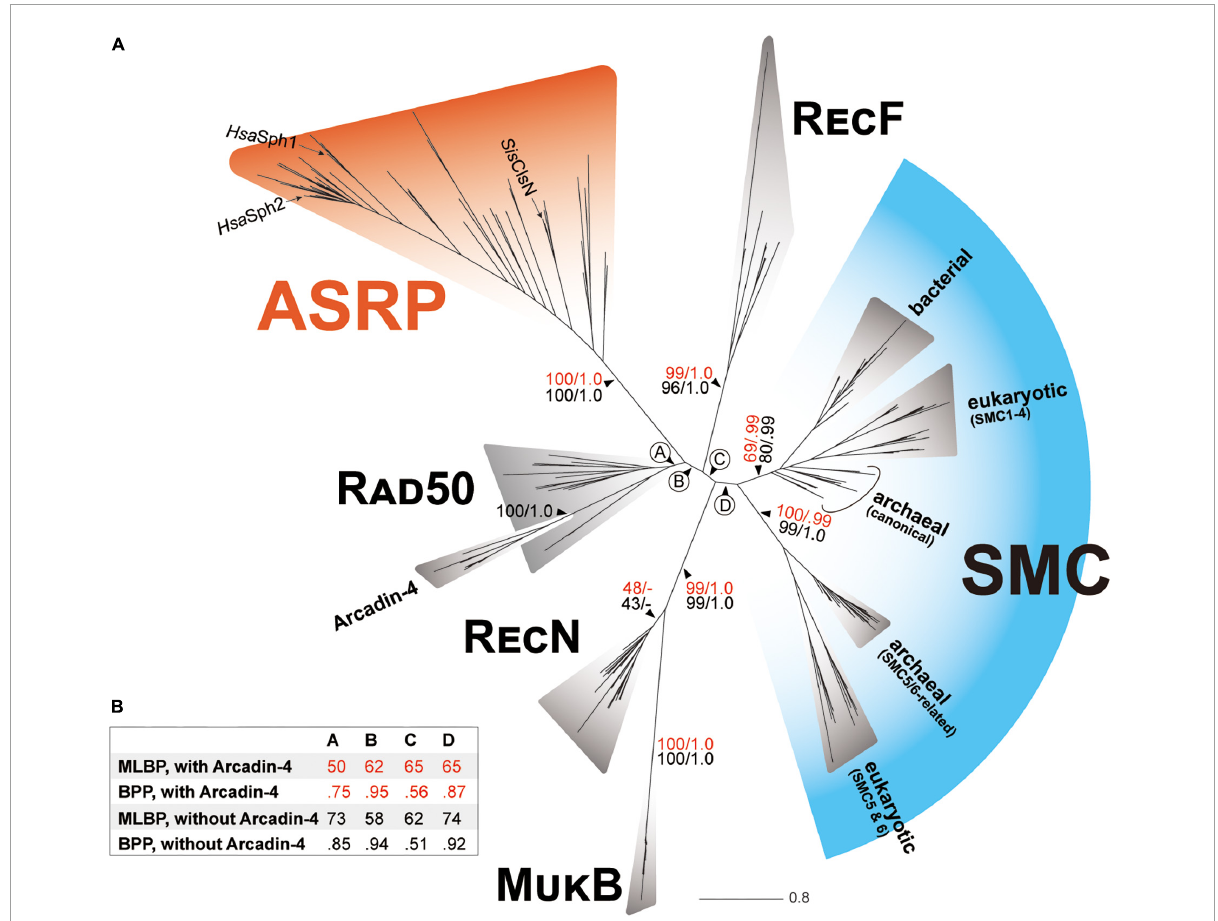
FIGURE1 Phylogenetic relationship among SMC and SMC-related proteins. (A) The ML tree inferred from the SMC-superfamily alignment. There was no substantial incongruity between the ML and Bayesian trees, and thus only the ML tree is shown. For the major nodes, non-parametric ML bootstrap support values (MLBPs) and Bayesian posterior probabilities (BPPs) are presented (the support values are colored in red). We repeated both ML and Bayesian analyses on the same alignment after the exclusion of the Arcadin-4 sequences. The overall tree topology remained the same before and after the exclusion of the Arcadin-4 in the alignment and only MLBPs and BPPs calculated from the second set of the phylogenetic analyses are presented for the major nodes (shown in black). The archaeal sequences identified in this study, together with Sulfolobus islandicus ClsN and Halobacterium salinarum Sph1 and Sph2 ( Sis ClsN, Hsa Sph1, and Hsa Sph2; the corresponding terminal branches were marked by arrows), formed a clade with full statistical support. This clade is termed “ASRP (Archaea-specific SMC-related protein).” (B)